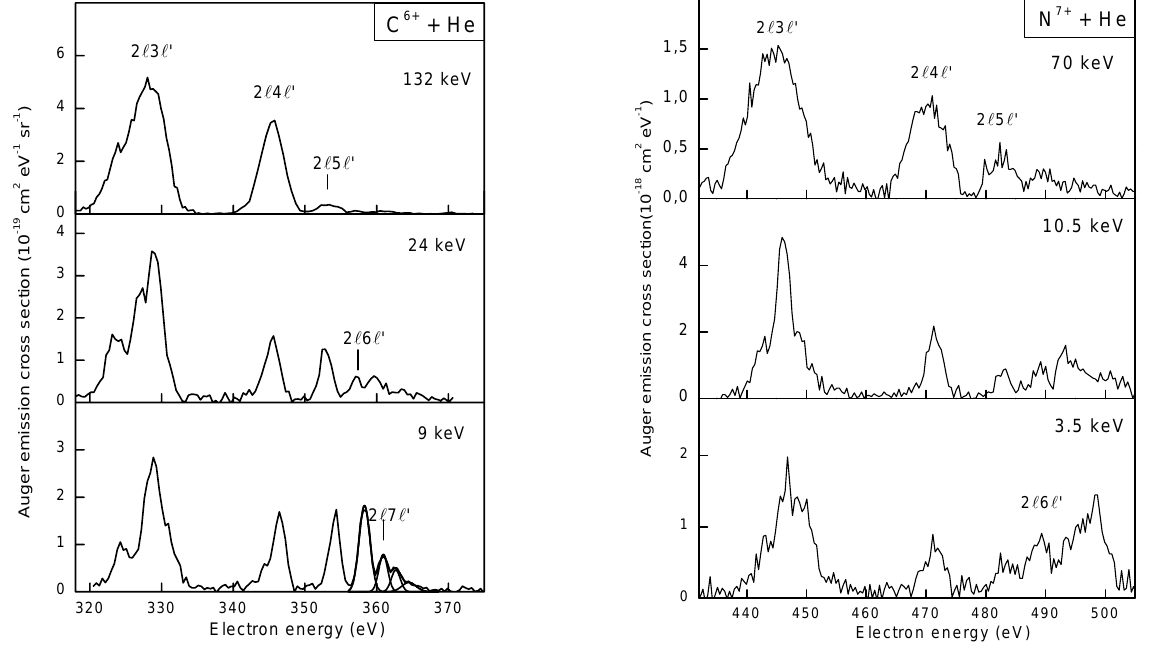
6+ 7+ + He and N + He collisions